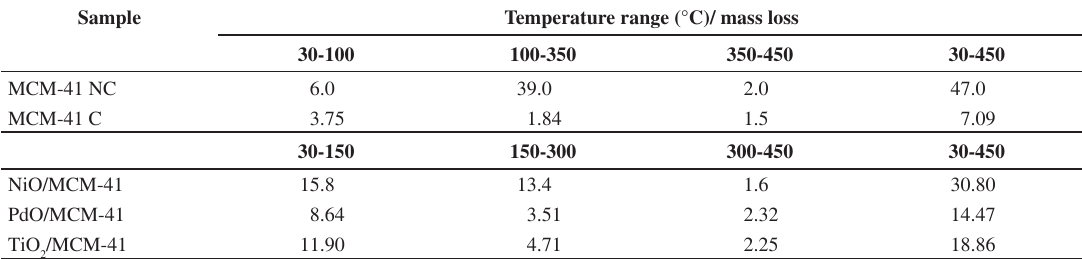
Figure 3. TG curves for (a) MCM‑41 calcinated (C) and non‑calcinated (NC); (b) NiO/MCM‑41; (c) PdO/MCM‑41 and (d) TiO Table 1. Mass loss (%) and temperature range (°C) for decomposition of MCM‑41 and MCM‑41 modified materials precursors. NC = non‑calcinated and C = calcinated.